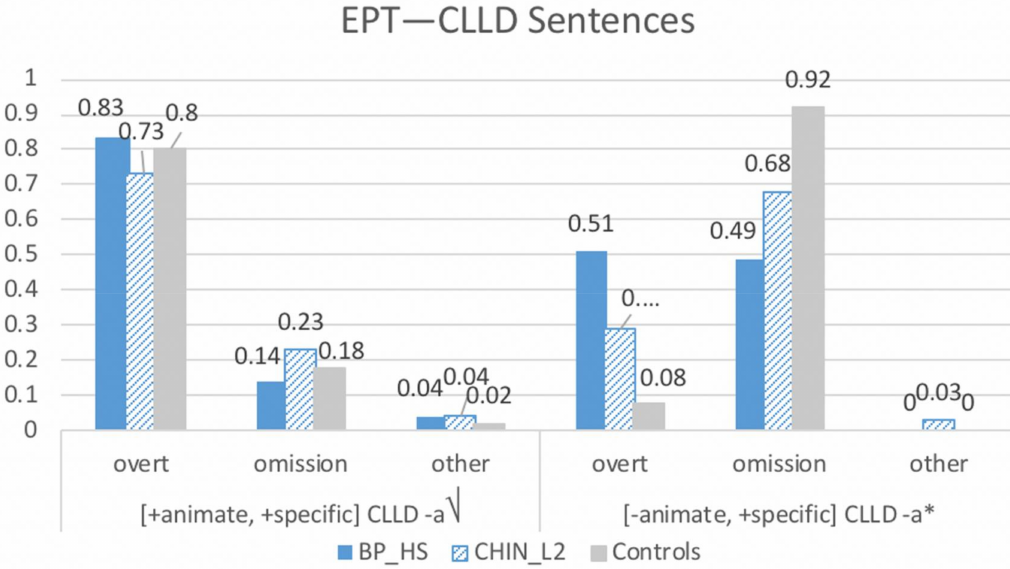
Figure 2. Elicited production task: proportion of DOM use, omission and other structures realized per group in clitic left-dislocated (CLLD)